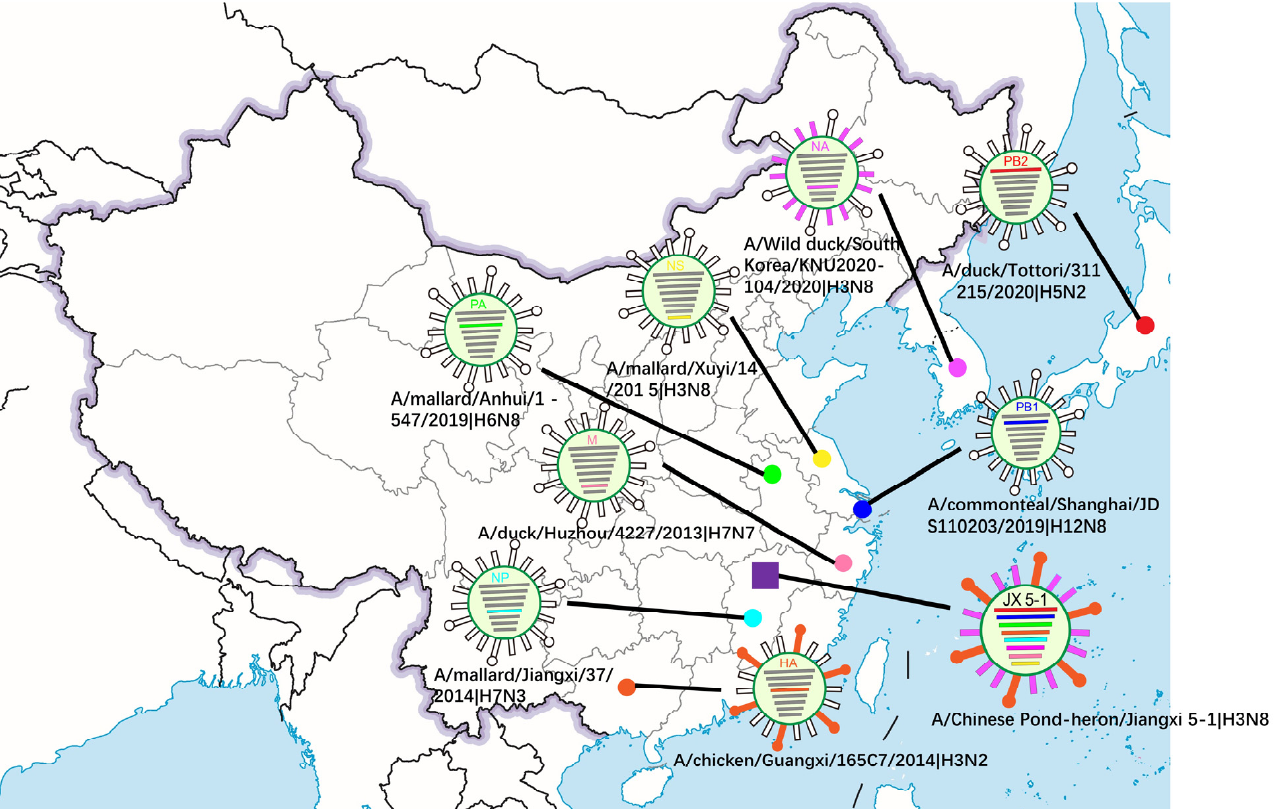
Figure 1. Phylogenetic analysis of HA ( A ), NA ( B ) of JX 5-1. The phylogenetic trees were constructed using gene sequences identified in NCBI or GISAID Blast analyses. JX 5-1 is marked in red, the closest related sequence is marked in blue. The trees were built using BEAST (v1.8.4) and illustrated using FigTree (v1.4.2).